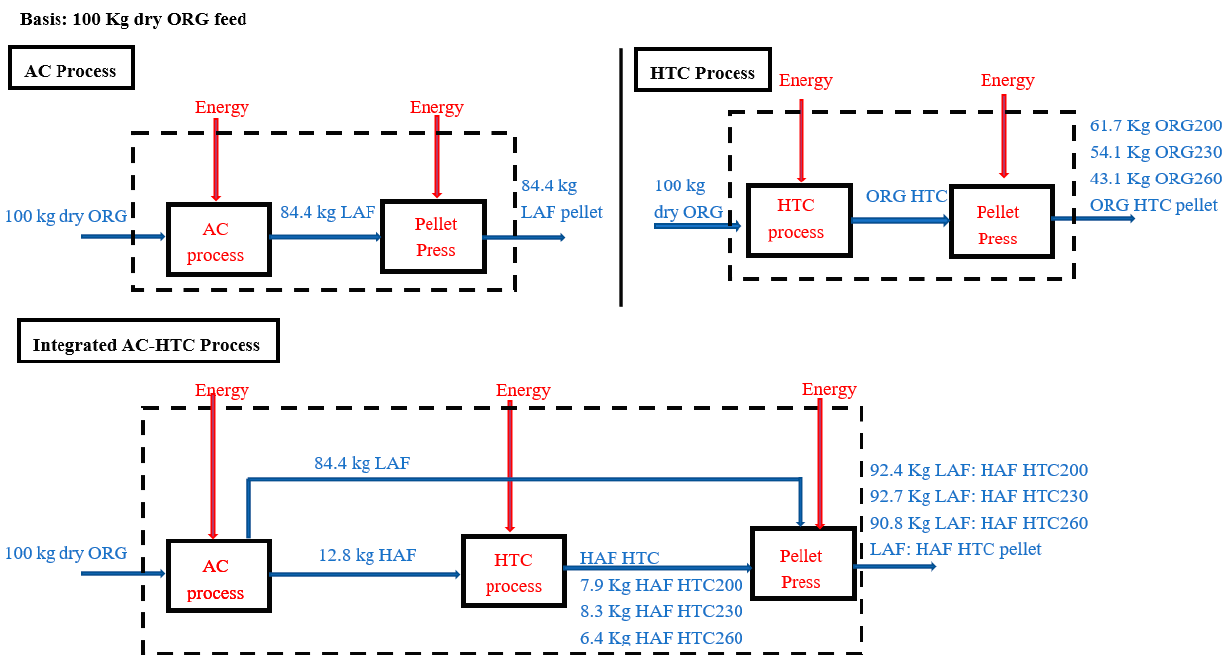
Figure 3. AC, HTC, and integrated AC–HTC process.